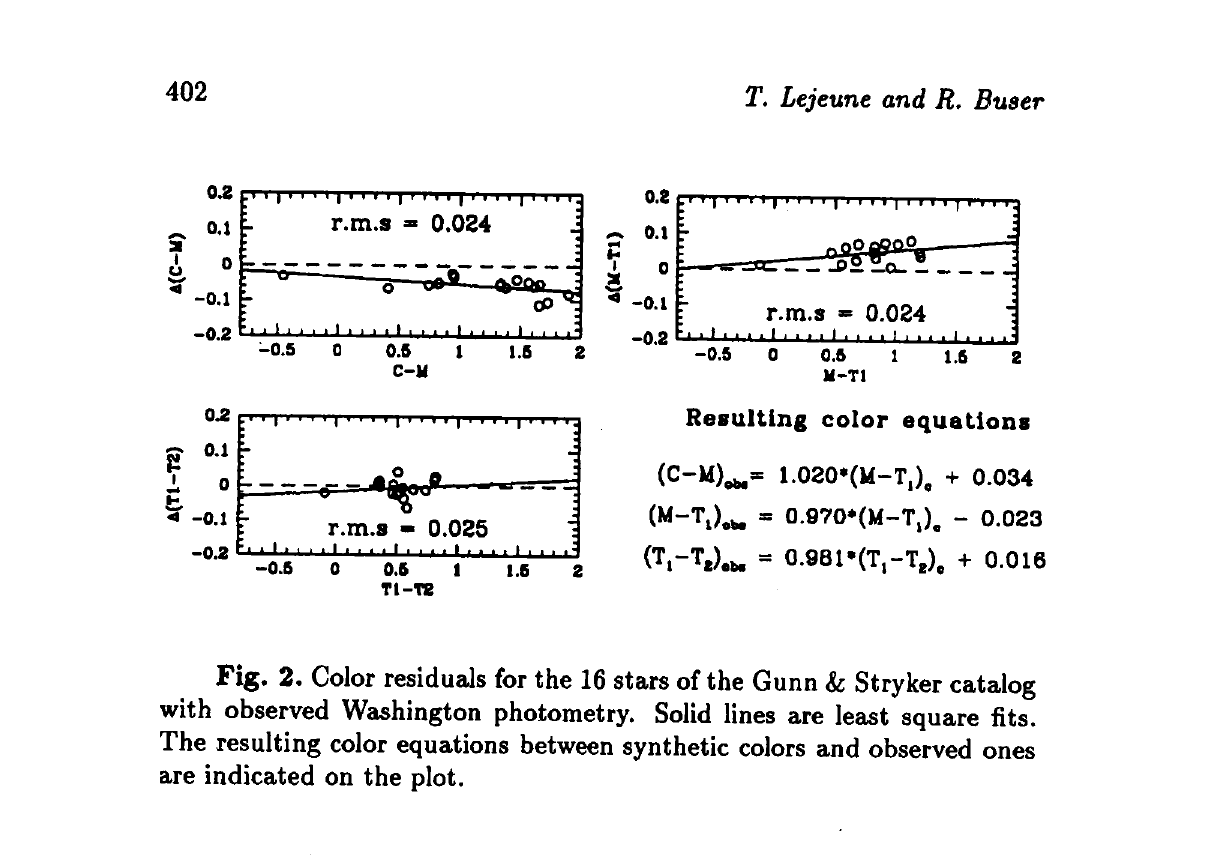
Fig. 2. Color residuals for the 16 stars of the Gunn & Stryker catalog with observed Washington photometry. Solid lines are least square fits. The resulting color equations between synthetic colors and observed ones are indicated on the